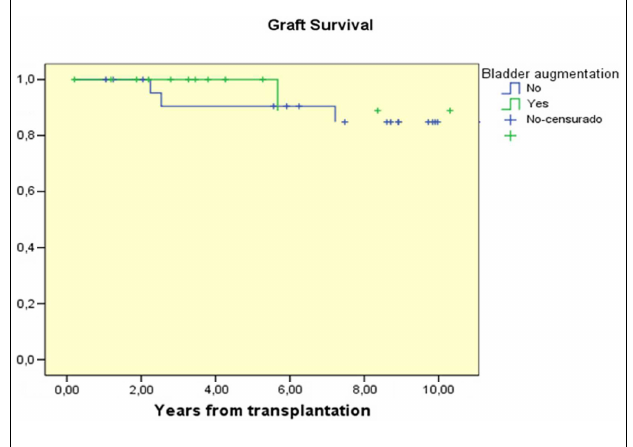
FIGURE 1 | Graft survival curves for children withAC prior to transplantation compared to those transplanted withoutAC